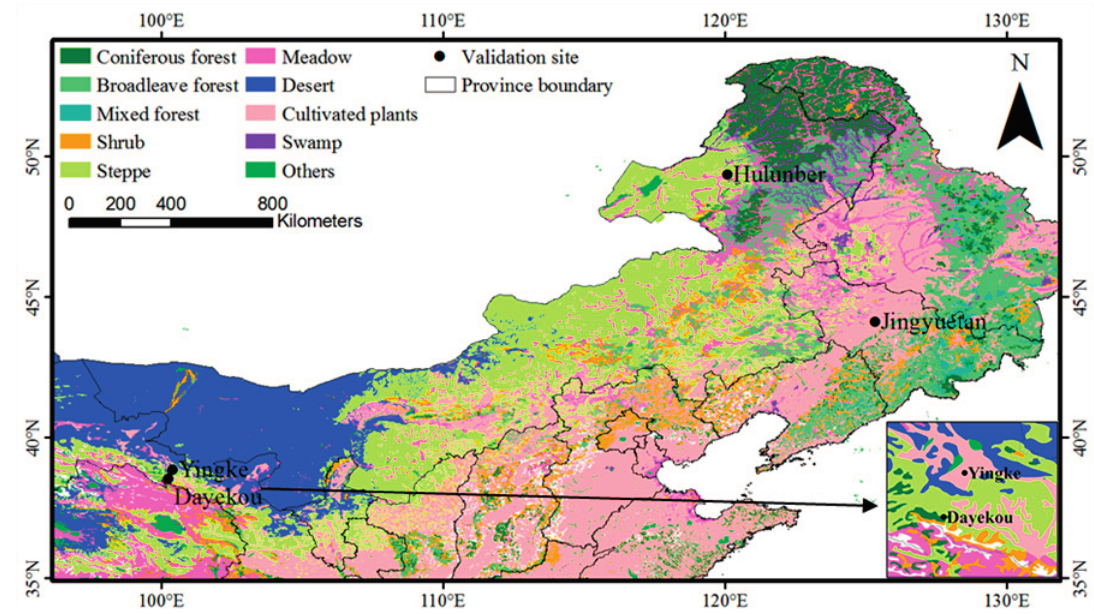
Figure 1. Validation site locations (vegetation type was obtained from a digitized 1:1,000,000 vegetation map of the People’s Republic of China